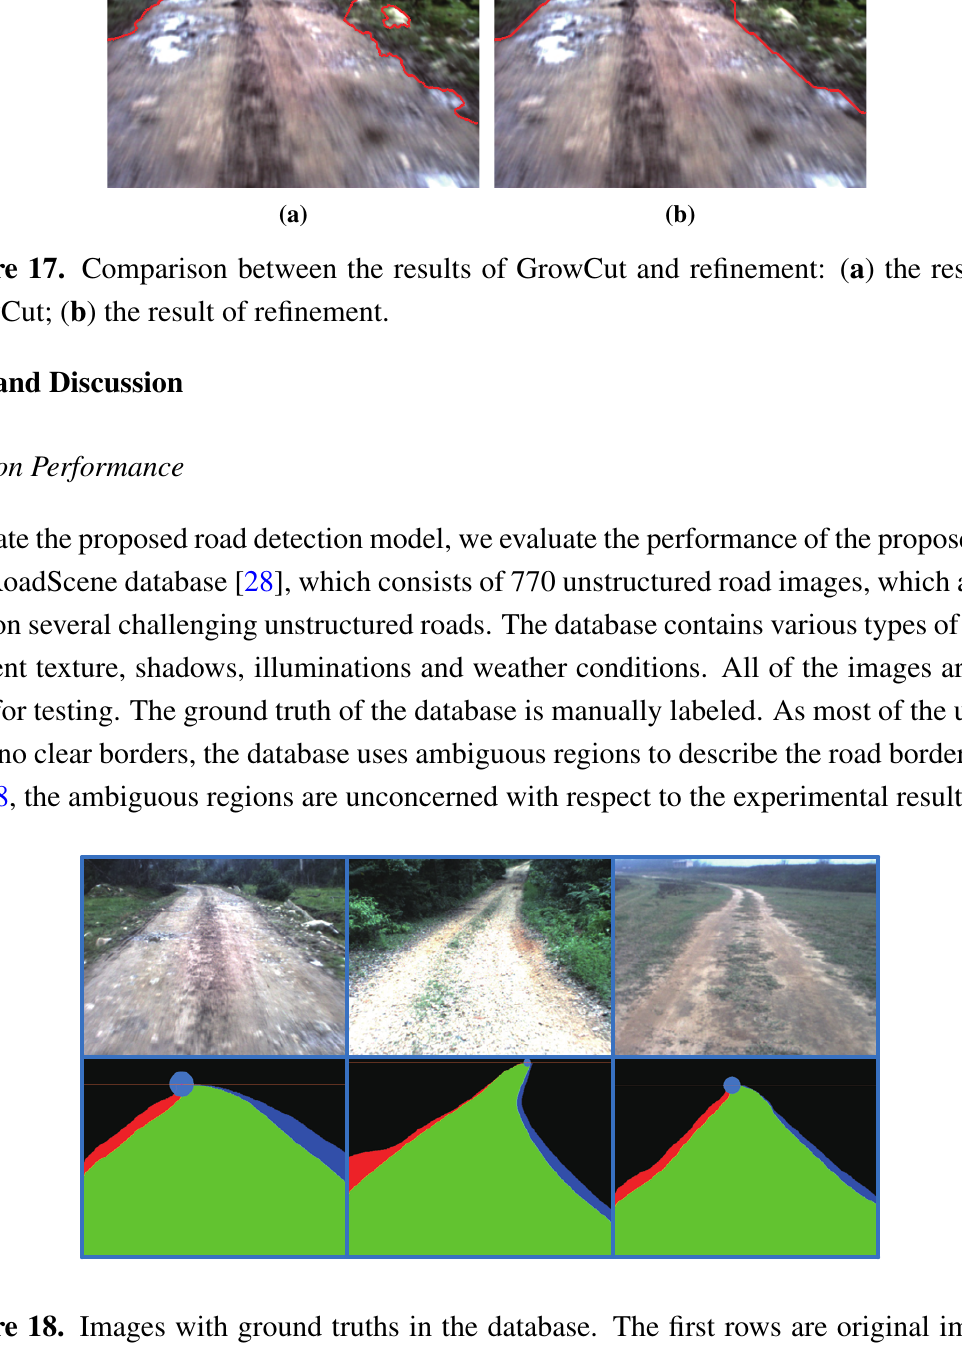
Figure 18. Images with ground truths in the database. The first rows are original images; the second rows are the corresponding ground truths; the road region is marked with the green color; ambiguous regions of the left and right edges are marked with red and blue colors,